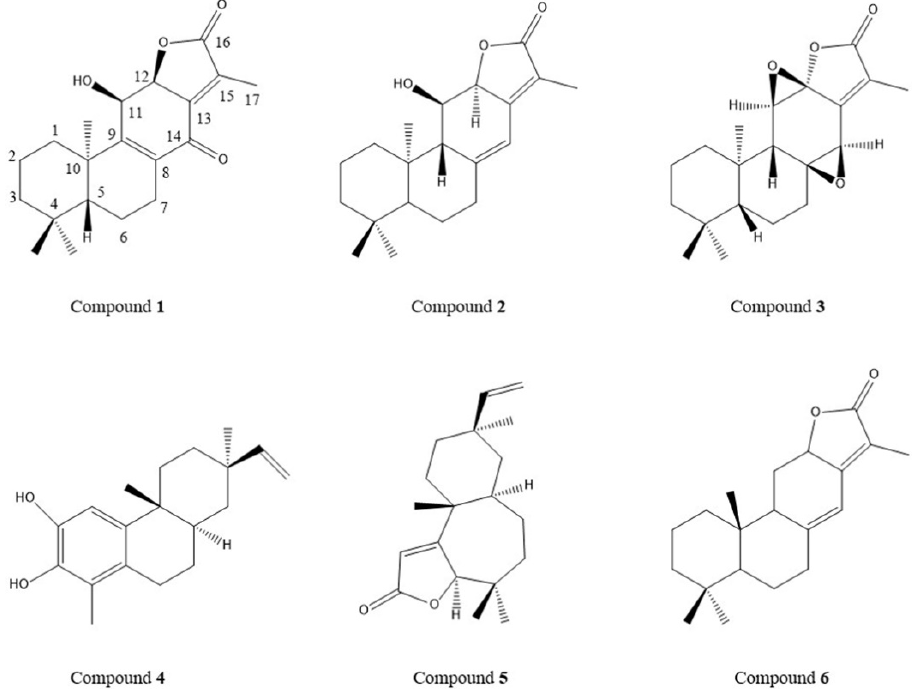
Figure 5. The chemical structures of six diterpenoid compounds. Compound 1 : euphorin G; compound 2 : ent-11 α -hydroxyabicta-8(14),13(15)-dien-16,12-olide; compound 3 : jolkinolide B; compound 4 : euphebracteolatin A; compound 5 : fischeria A; compound 6 : jolkinolide E.